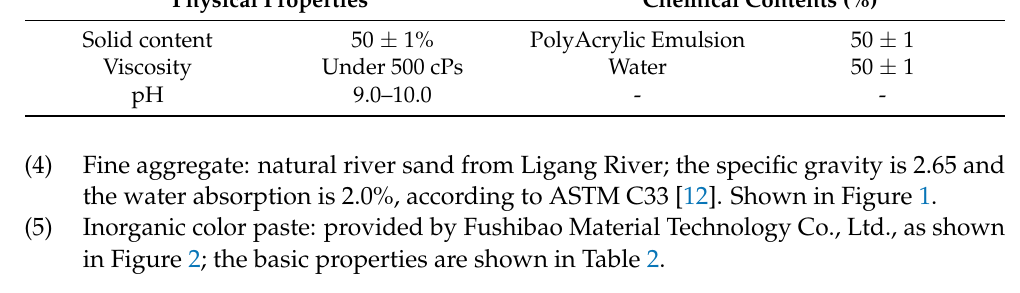
Table 1. The physical and chemical properties of polyacrylic emulsion. Table 2. The physical properties of inorganic color paste.